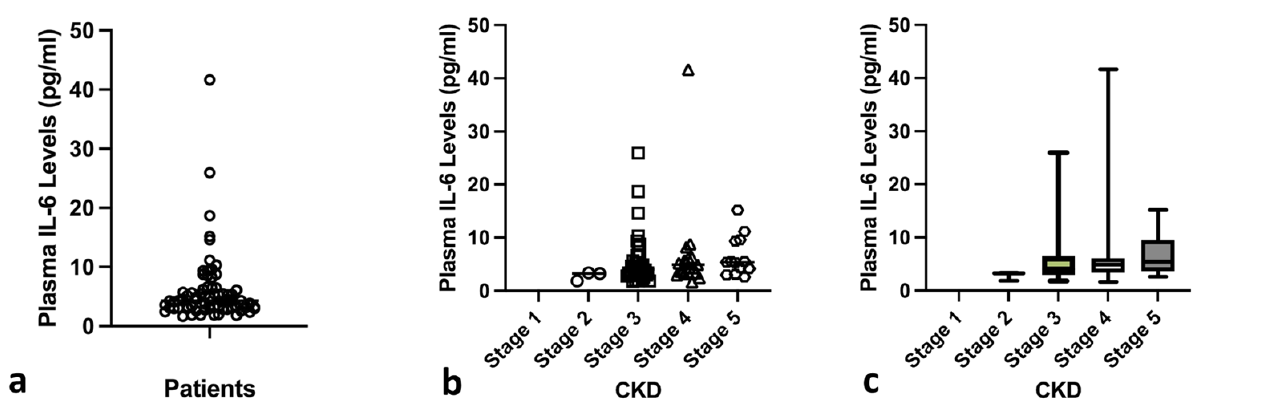
Figure 1. The level of plasma IL-6 in: ( a ) total patients; ( b ) patients were stratified according to CKD stages; ( c ) box-plot of plasma IL-6 levels based on CKD stages.